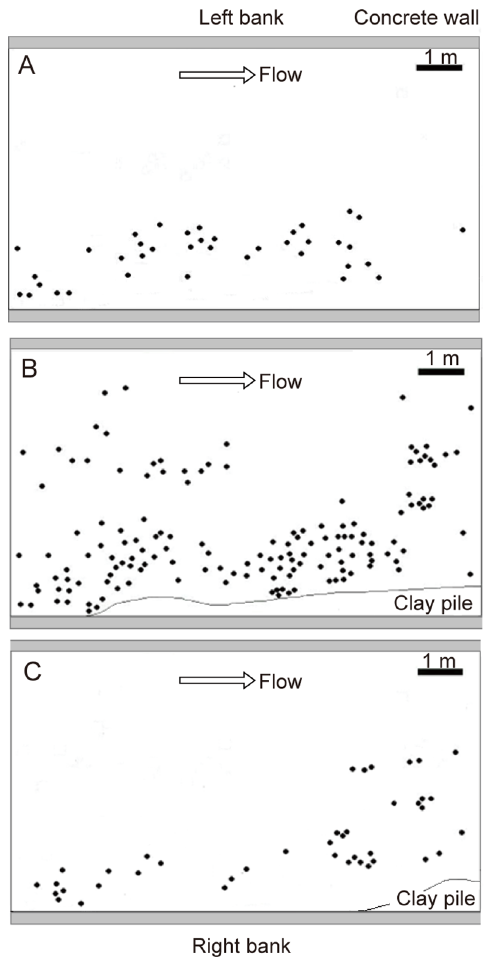
Fig 4. The spatial distribution at the study site. The positions of S . gemmifer are indicated by black dots. (A), (B) and (C) illustrate the spatial patterns on Dates I, II and IV, respectively. A pile of clay was present in (A), although its precise shape was not recorded. Dates I – IV are defined in the text.